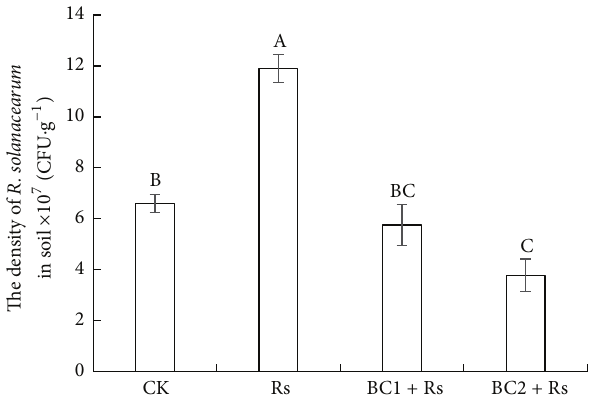
Figure 3: Effects of biochar amendment and R. solanacearum inoc- ulation on R. solanacearum density in soil. CK, no biochar and no R. solanacearum inoculation; Rs, R. solanacearum inoculation; BC1 + Rs, peanut biochar amendment and R. solanacearum inoculation; BC2 + Rs, wheat biochar (BC2) amendment and R. solanacearum inoculation. Different letters on the columns denote a significant difference at 𝑃 < 0.05 using the DMRT (Duncan’s new multiple range tests)